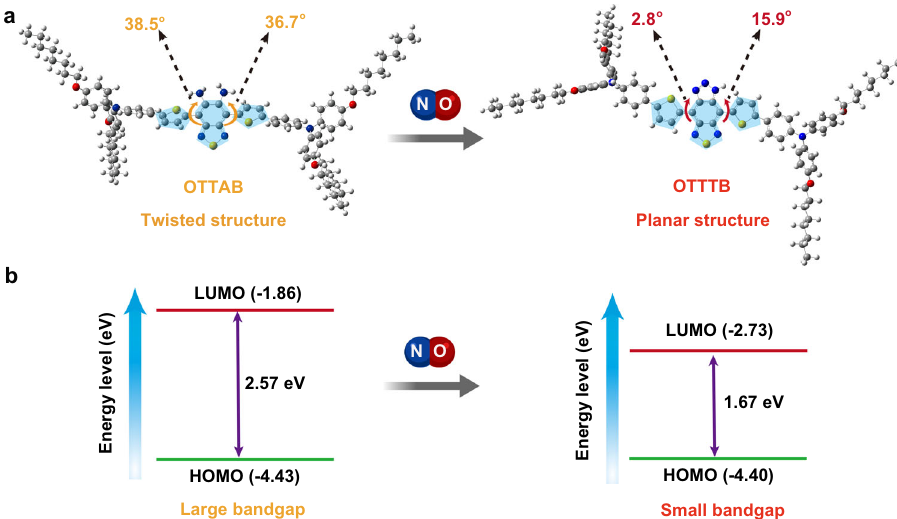
Fig. 3 Changes of molecular conformation and energy level after NO treatment. a The optimized molecular geometries and b corresponding changes in the electronic energy levels of OTTAB before and after NO